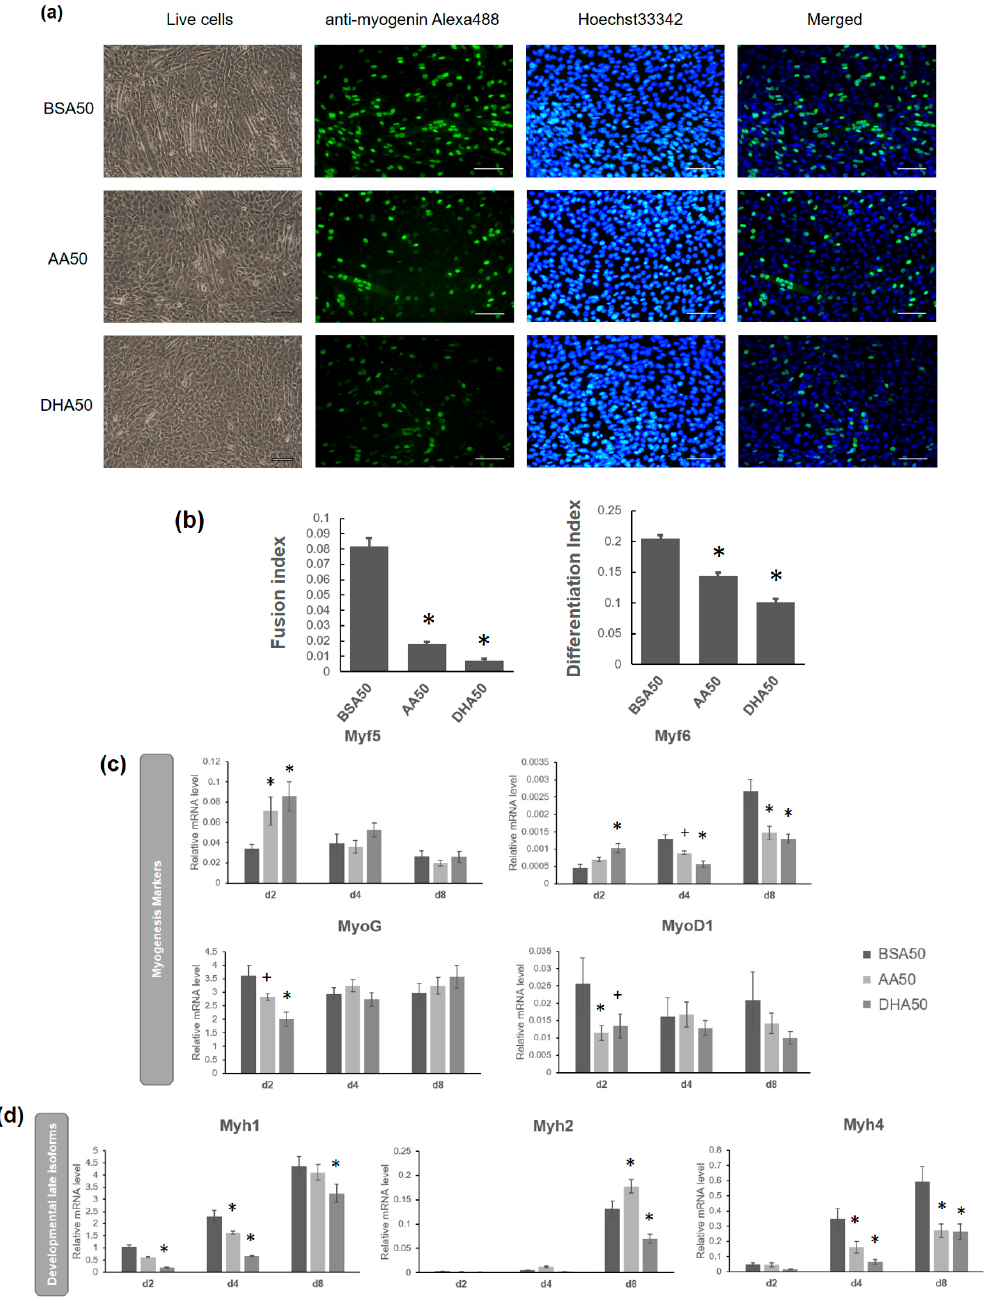
Figure 4. The effect of 50 μ M PUFA on C2C12 myotubes formation. ( a ) Immunofluorescence staining using Anti-Myogenin Alexa Fluor ® 488 and Hoechst 33342 staining on C2C12 myotubes at day 2 (d2) of the treatment. Scale bar for live cells is 100 μ m, Scale bar for anti-myogenin Alexa488, Hoechst 33342 staining and merged is 200 μ M. ( b ) Quantification of differentiation index and fusion index are shown. The mRNA level of myogenesis markers at three time points (d2 (2 days treatment), d4 (2 days treatment plus 2 days recovery), d8 (2 days treatment plus 6 days recovery)) was shown. ( c ) At d2, Myf5 expression level was induced in both AA50 and DHA50 treatment. MyoG expression level was significantly de-